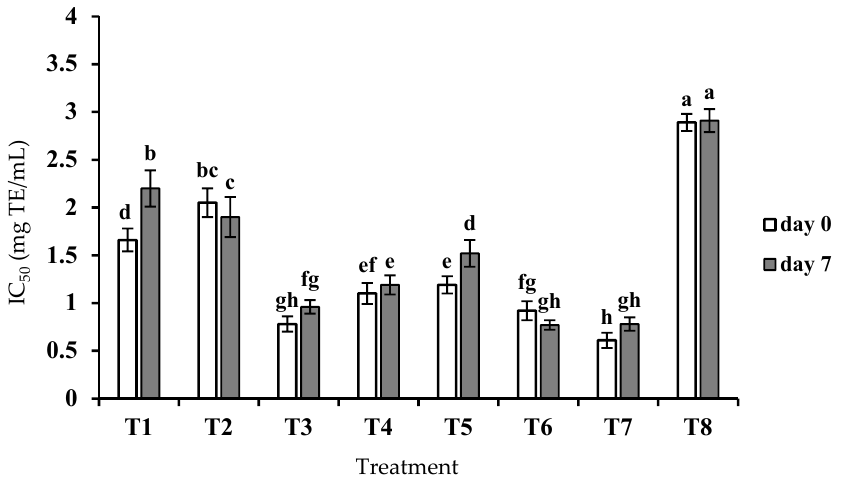
Figure 2. ACE inhibitory activity based on IC 50 of peptide content equivalent to tryptone in fermented milk samples after fermentation (day 0) and after 7 days of storage. T1, T2, and T3 indicate fermented milk with L. delbruekii subsp. bulgaricus ORT2, L. reuteri SRM2, and L. lactis subsp. lactis BRM3, respectively; T4: fermented milk with L. delbruekii subsp. bulgaricus ORT2 and L. reuteri SRM2; T5: fermented milk with L. delbruekii subsp. bulgaricus ORT2 and L. lactis subsp. lactis BRM3; T6: fermented milk with L. lactis subsp. lactis BRM3 and L. reuteri SRM2; T7: fermented milk with L. delbruekii subsp. bulgaricus ORT2, L. reuteri SRM2 and L. lactis subsp. lactis BRM3; T8: acidified milk with lactic acid. Different lowercase letters on each column show significant differences ( p < 0.05) among the fermented samples during 7 days of storage.